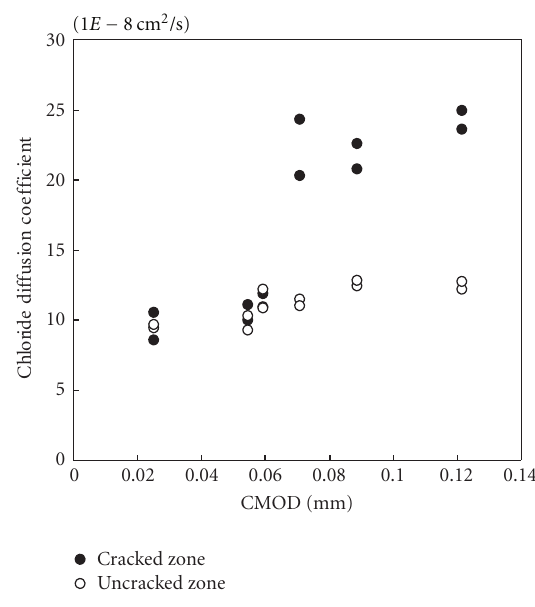
Figure 11: Chloride di ff usion coe ffi cient for PT-treated concrete. Figure 12: Chloride di ff usion coe ffi cient for CT-treated